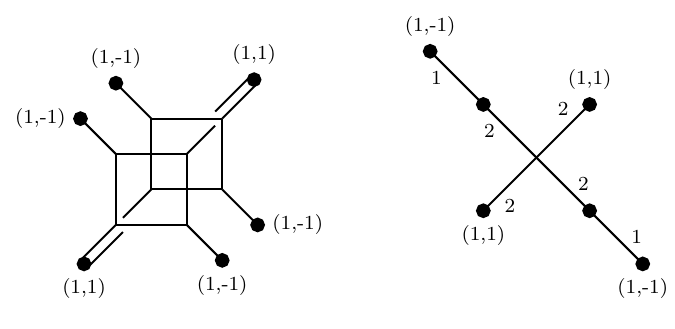
Figure 6 . Brane web for SU(4) 0 +2 AS